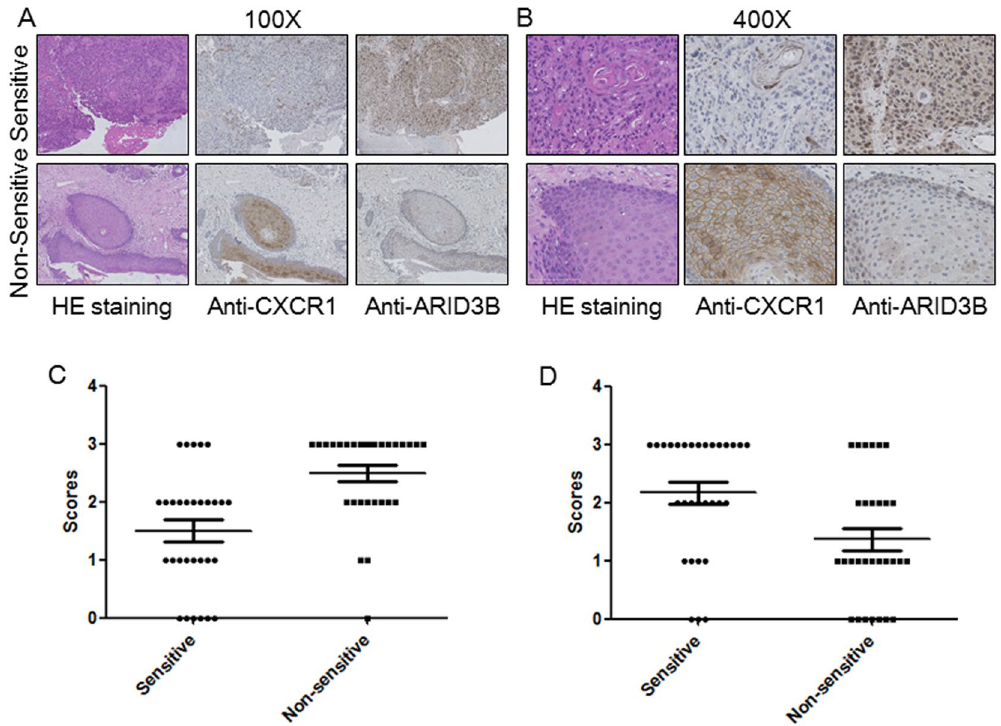
Figure 3. Immunostaining of candidate genes. ( A , B ) Presentative IHC images of CXCR1 and ARID3B with different ( A ) 100X; ( B ) 400X. ( C ) Statistical analysis of the immunohistochemistry results for CXCR1 and ARID3B. Student t-test, * p < 0.05, ** p <